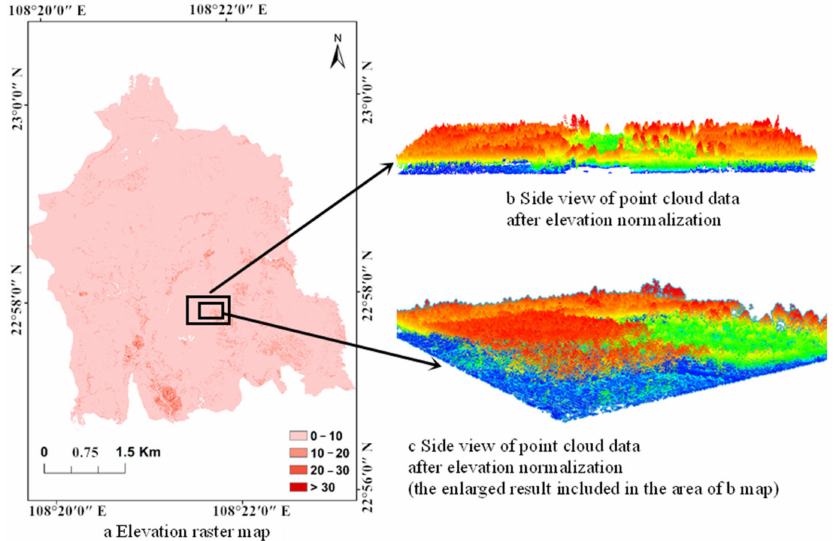
Figure 2. Elevation normalization of point cloud ( a ) is the elevation raster map. ( b ) is the side view of point cloud data after elevation normalization. ( c ) is the enlarged result of ( b ).